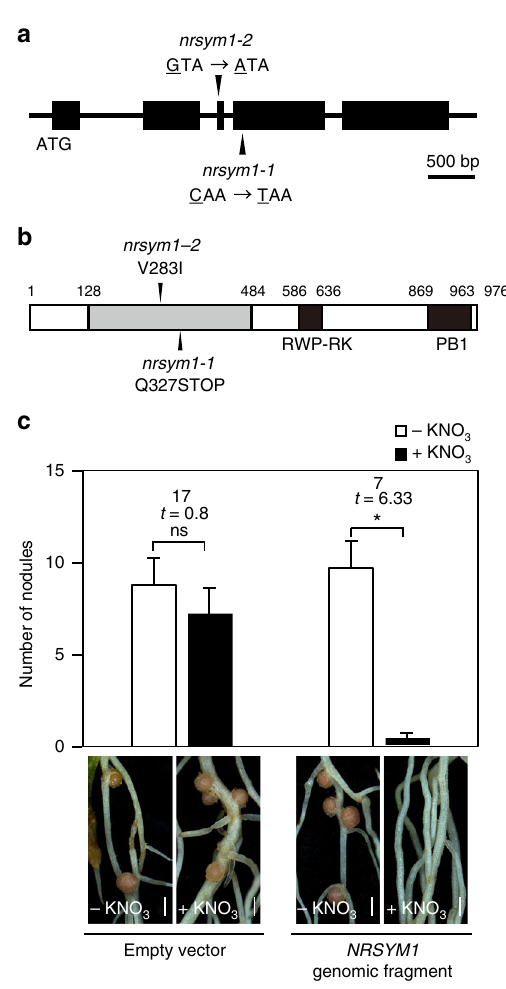
Fig. 3 Structure of the NRSYM1 gene. a Exon – intron structure of the NRSYM1 gene. Black boxes indicate exons. Arrowheads indicate locations of the nrsym1 mutations. b Structure of the deduced NRSYM1 protein. An N- terminal conserved region is indicated by the gray box. C-terminal regions containing an RWP-RK DNA-binding domain (RWP-RK) and a conserved domain (PB1) are shown as black boxes. Arrowheads indicate locations of the nrsym1 mutations. c Complementation of the nrsym1 nodulation phenotype. Representative transgenic hairy roots of L. japonicus carrying a control empty vector or a 7.5-kb genomic fragment encompassing the entire NRSYM1 locus. Transgenic roots were identi fi ed by GFP fl uorescence. The number of nodules was counted in the transgenic roots of nrsym1-1 mutants containing either an empty vector or a genomic fragment of NRSYM1 in the presence of 0 or 10 mM KNO n = 8 – 10 plants). 3 at 21 dai ( * P < 0.05 by Student ’ s t -test. ns, not signi fi cant. Degrees of freedom are shown above the t -values. Error bars indicate SEM. Scale bars: 1